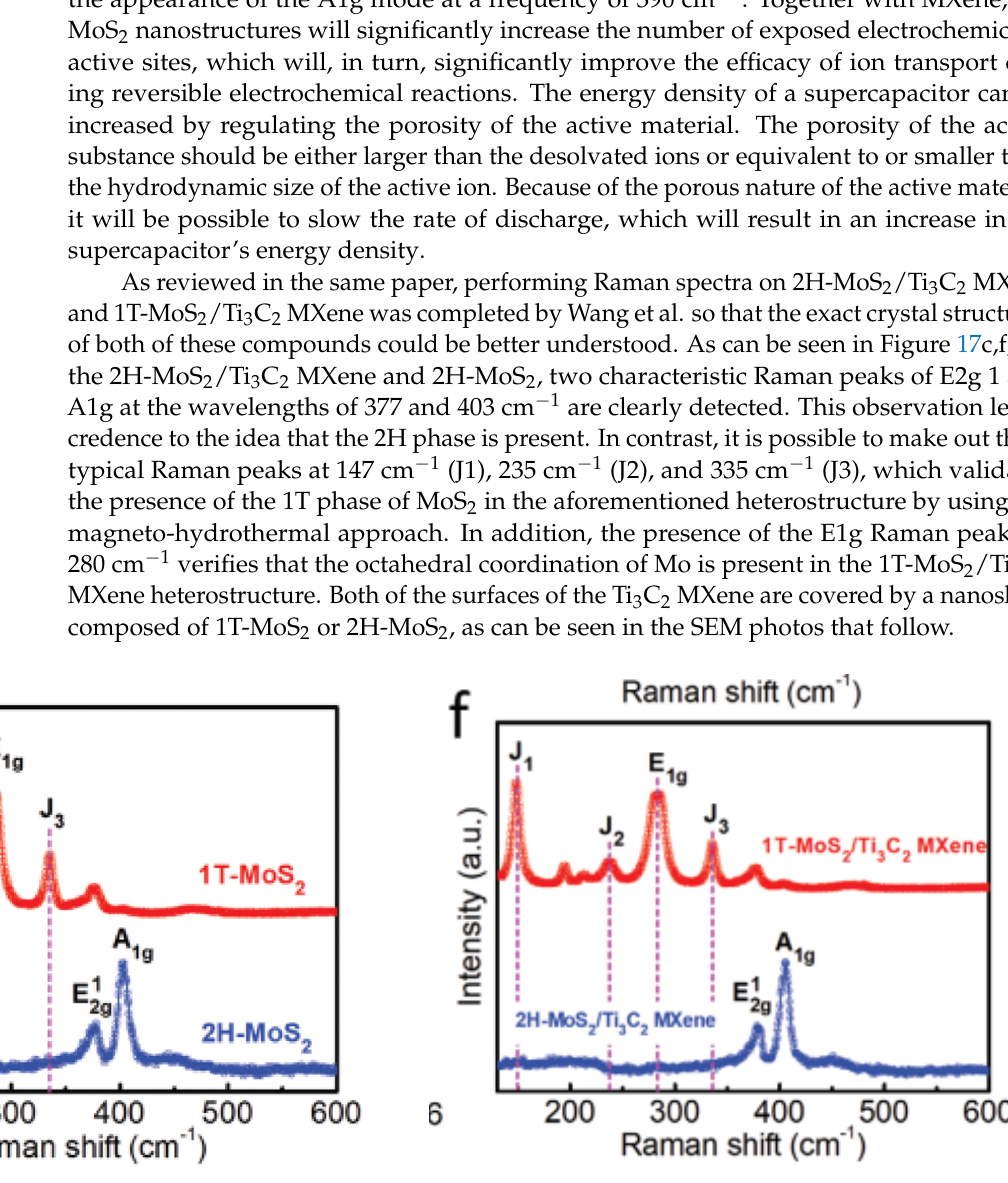
Figure 17. Raman spectra of the 2H-MoS 2 /Ti 3 C 2 MXene and 1T-MoS 2 /Ti 3 C 2 MXene. ( c ) Raman spectra of the 2H-MoS 2 and 1T-MoS 2 , ( f ) Raman spectra of the 2H-MoS 2 /Ti 3 C 2 MXene and 1T-MoS 2 /Ti 3 C 2 MXene. Reproduced with permission from [87]. Copyright 2019 Wiley.